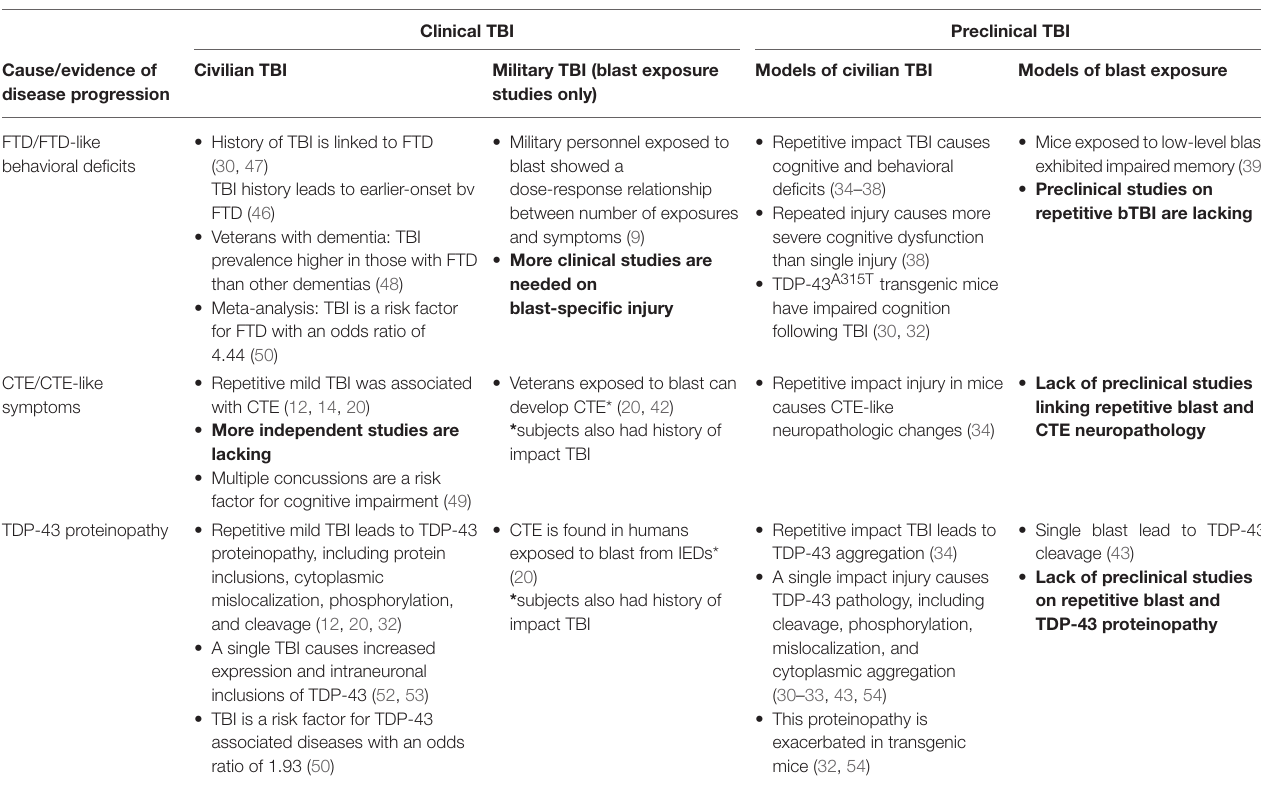
TABLE 1 | Summary of previous research conducted on TBI, TDP-43, and